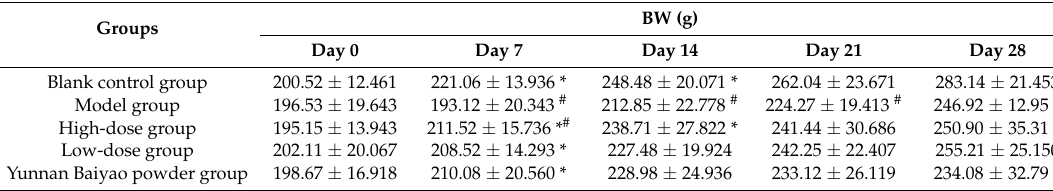
Table 1. Effect of brucine gel on body weight (BW).